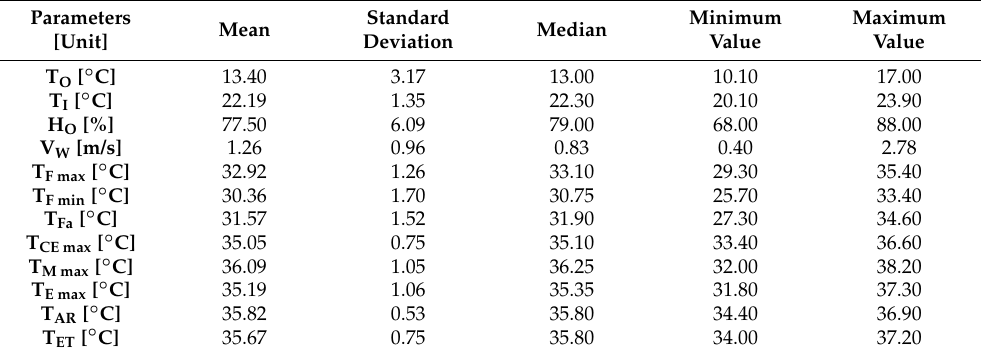
Table 1. Averaged climatic data and temperature values obtained from the analysis of thermograms and measured with thermometers.